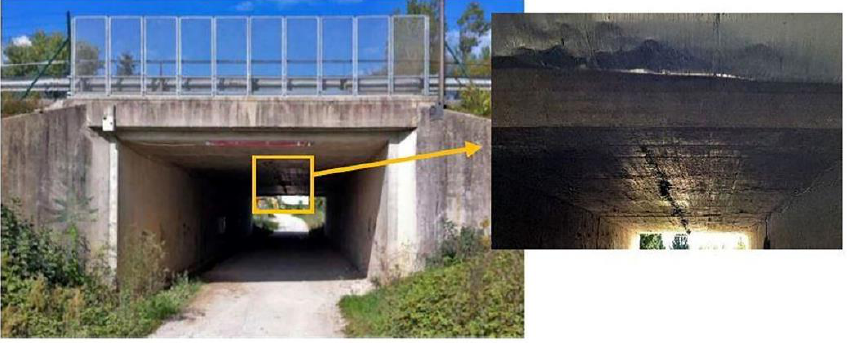
Figure 11. The Šentvid bridge in Slovenia .